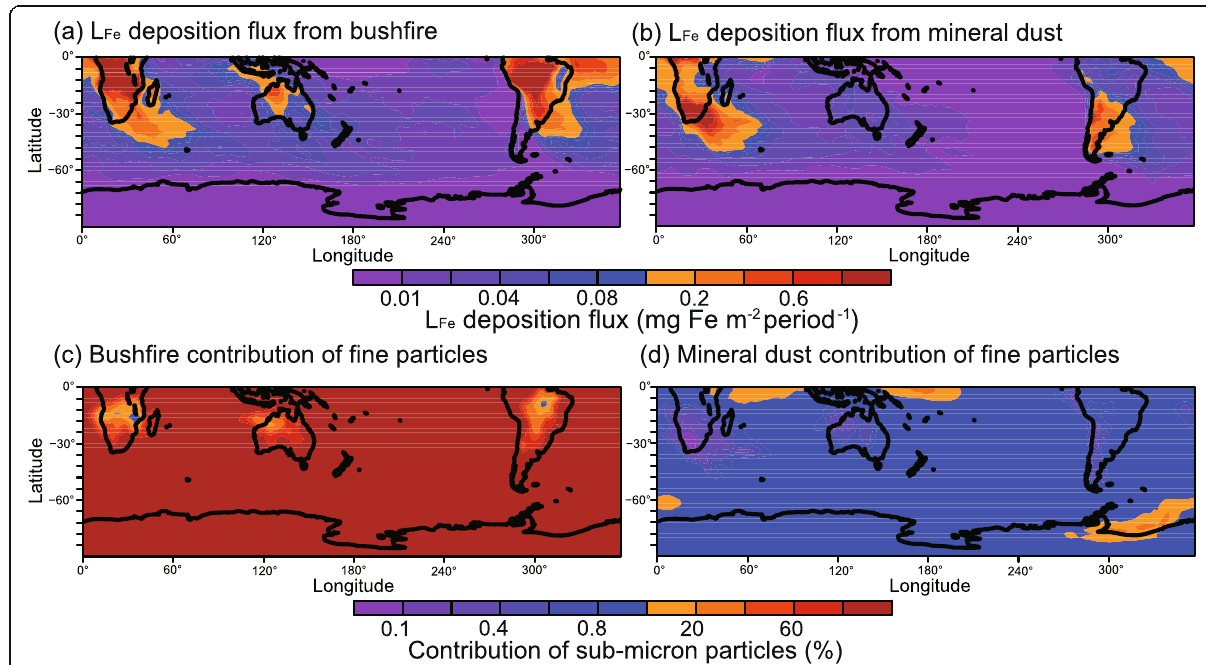
Fig. 10 Spatial distribution of L Fe deposition fluxes from a bushfire and b mineral dust (mg Fe m – 2 period – 1 ) and the contribution of sub-micron particles from c bushfire and d mineral dust (%) in the SH for 2017 during the austral spring (September – October – November) when bushfires peak in